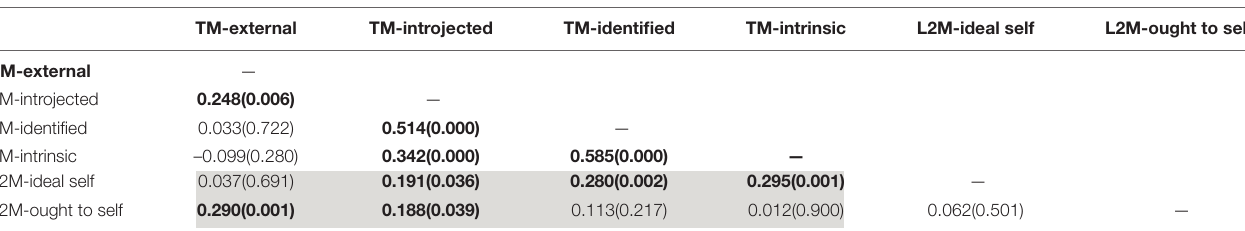
TABLE 2 | Correlations between teacher motivation and L2 motivation ( N =